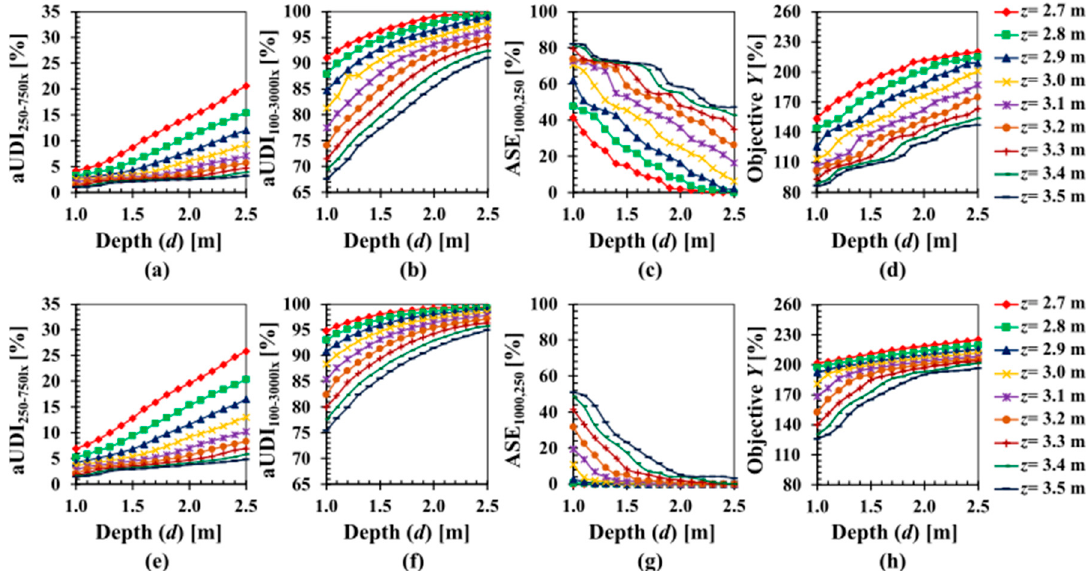
Figure 6. Simulation results at orientation of 0° for metrics ( a ) aUDI 250–750lx , ( b ) aUDI 100–3000lx , ( c ) ASE 1000,250 , and ( d ) objective function Y ; and at orientation of 45° for metrics ( e ) aUDI 250–750lx , ( f ) aUDI 100–3000lx , ( g ) ASE 1000,250 , and ( h ) objective function Y.